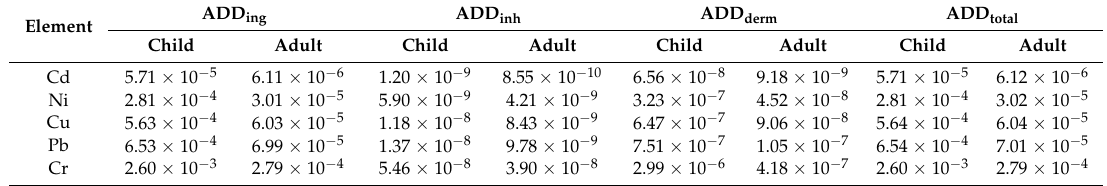
Table 4. Exposure doses of heavy metals in the dust of urban leisure squares in different ways.